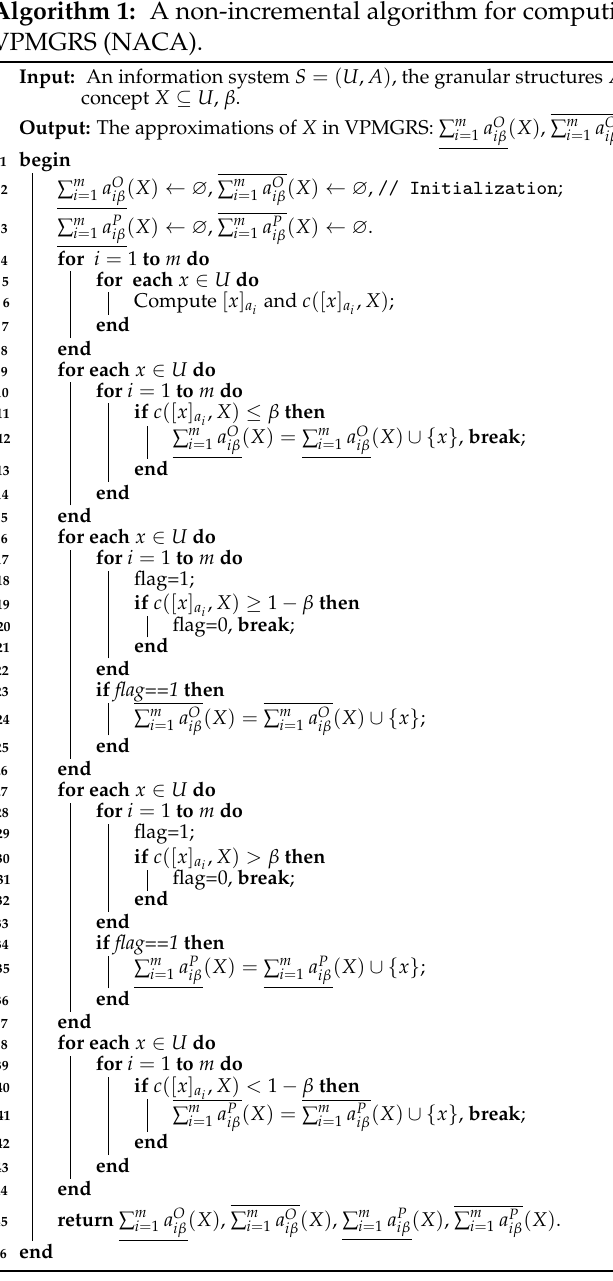
Algorithm 1: A non-incremental algorithm for computing approximations in VPMGRS